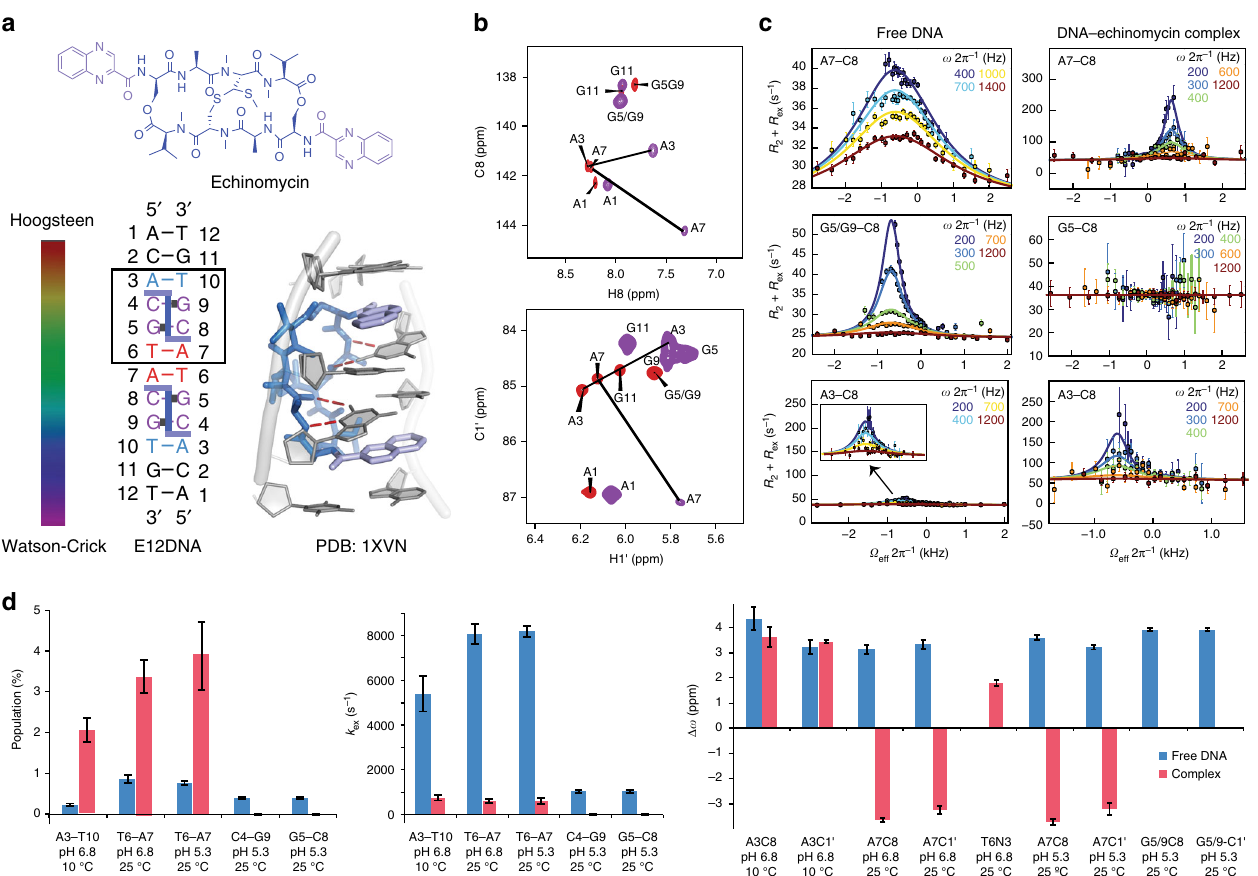
Fig. 2 Hoogsteen breathing in the DNA – echinomycin complex. a Chemical structure of echinomycin, crystal structure of the DNA – echinomycin complex (PDBID: 1XVN), and DNA construct used in NMR studies with color code showing Hoogsteen population (ranging between 0 to 100%). b Two- dimensional HSQC NMR spectra of DNA showing chemical shift perturbations on complex formation (red: free DNA; purple: complex). c Representative RD pro fi les measured in the free and bound duplex DNA showing modulation of Hoogsteen breathing on complex formation. Best fi ts to the Bloch – McConnell equations are shown. Error bars represent experimental uncertainty (one s.d.) derived using a Monte-Carlo method. d Comparison of exchange parameters measured in the free DNA and the DNA – echinomycin complex (Supplementary Table 1). RD and exchange parameters for G5/G9 are obtained from measurements on these overlapping resonances arising due to their very similar sequence contexts. Errors in all RD-derived fi tted parameters including population, k ex and Δ ω re fl ect experimental uncertainty (one s.d.) calculated by the Monte-Carlo approach from a single RD measurement containing more than 40 data points (see Methods). χ 2 < 1.5, P <